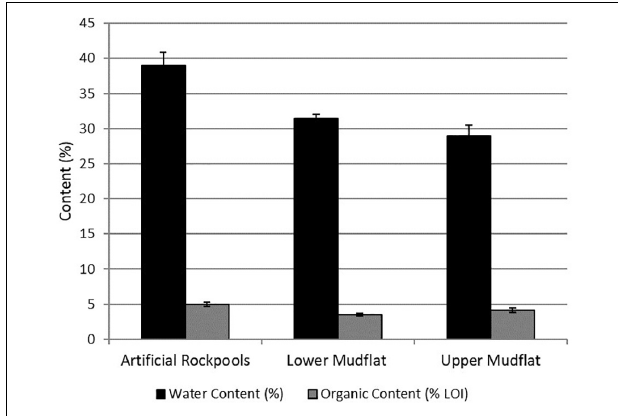
FIGURE 3 | Mean water and organic content in the soft-bottomed habitats expressed as percentage. Error bars show ± Standard Error ( n = 9).